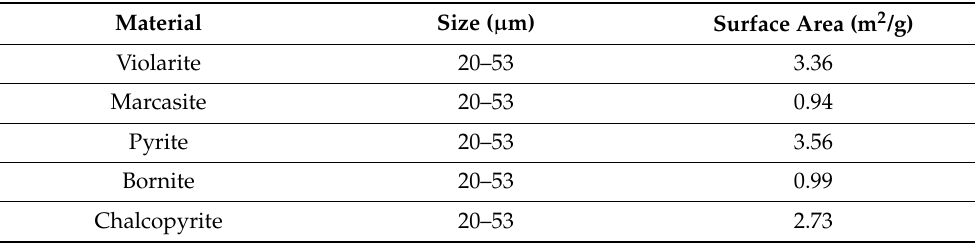
Table 2. Specific surface area of sulphide minerals using small-angle neutron scattering (SANS) and ultra-small-angle neutron scattering (USANS) [28].